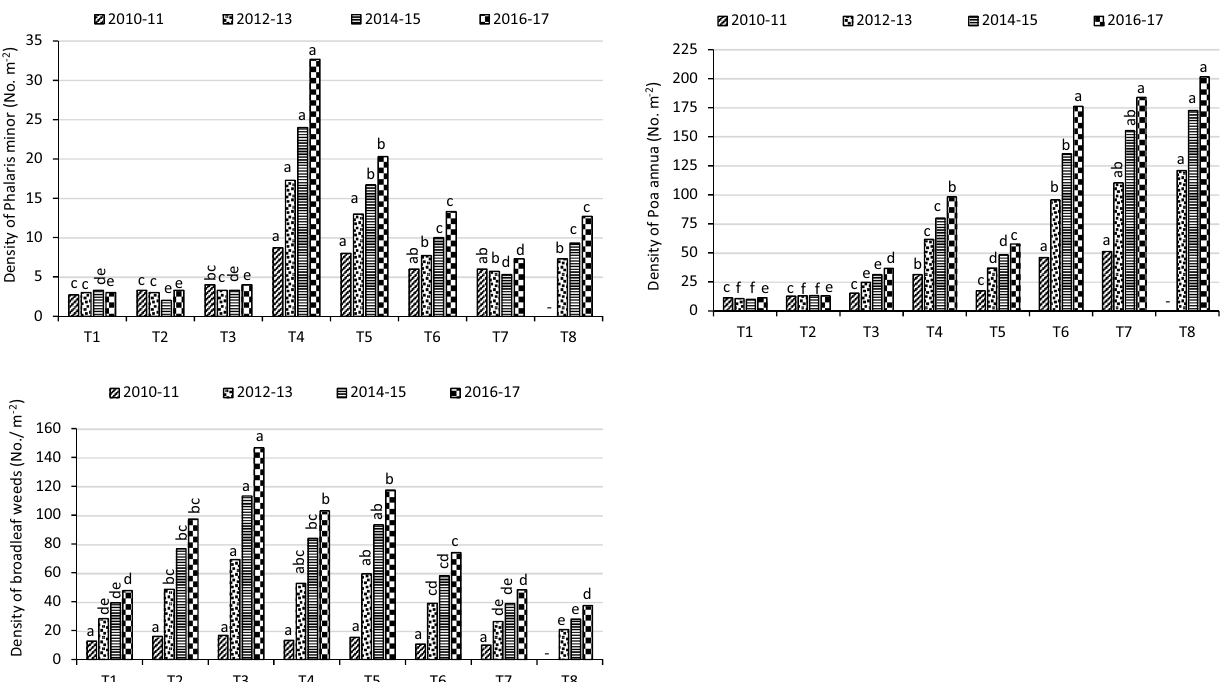
Fig. 2 Effect of different crop establishment methods on density of weeds in wheat under the rice–wheat cropping system (alternate years). The bars of a season with similar letters did not differ